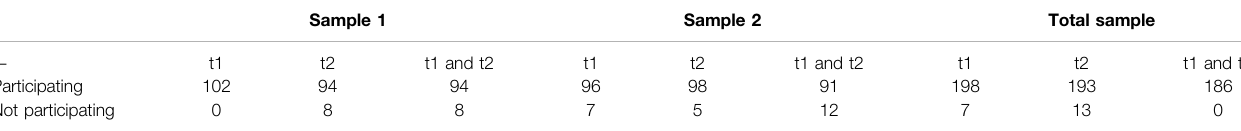
TABLE 1 | Study participation in the total sample and in both subsamples.